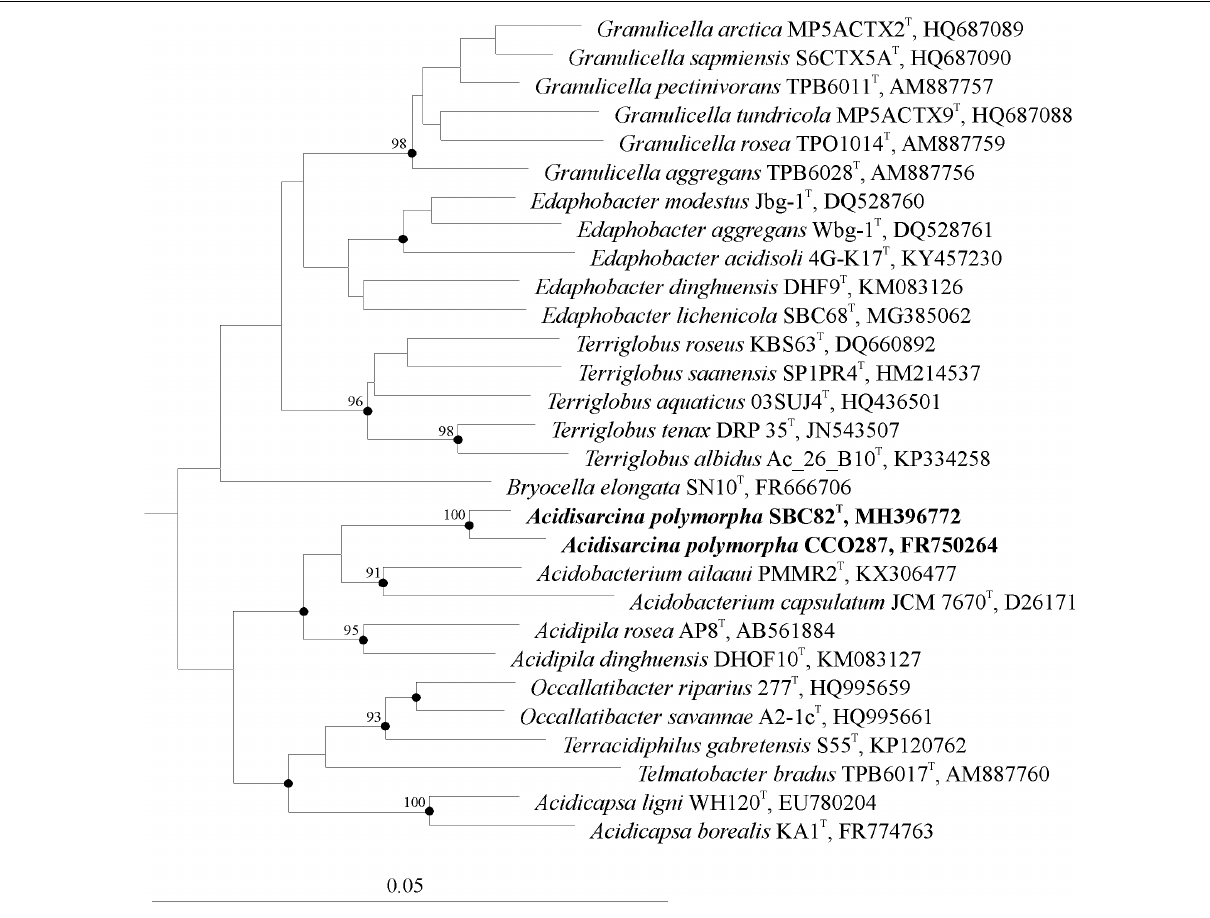
between 4.0 and 7.7 (optimum pH 4.8–7.0) and at